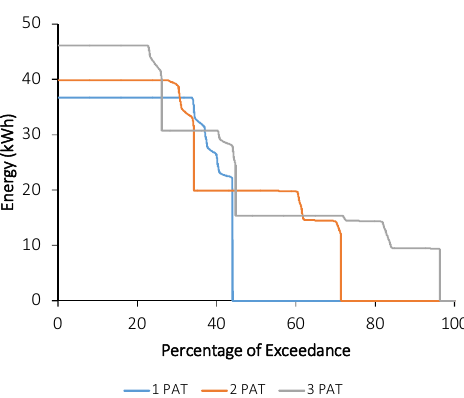
Figure 8. Energy production duration curve for one, two and three PAT installed in parallel.